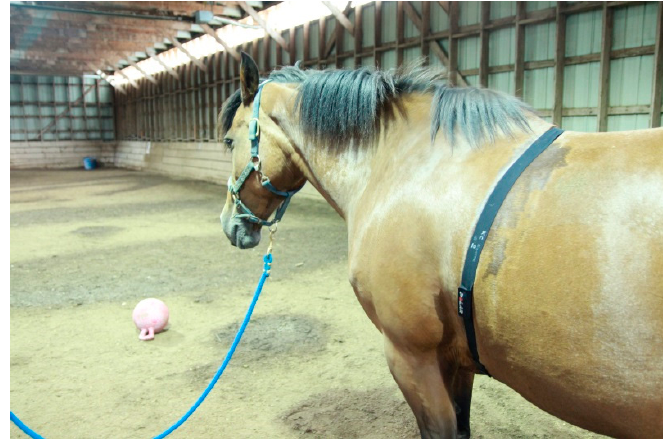
Figure 1. Horse with heart rate (HR) monitor (Polar RS800) during the startle test. The ball was tossed approximately 2 m in front of the horse. The handler maintained a fairly loose lead. The observer (not visible in this photo) was positioned about 3 m from the horse’s right eye.